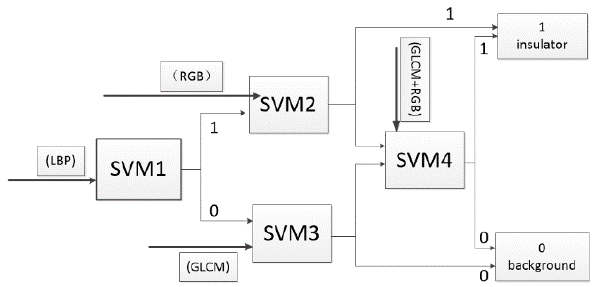
Figure 8. The structure of the classifier .